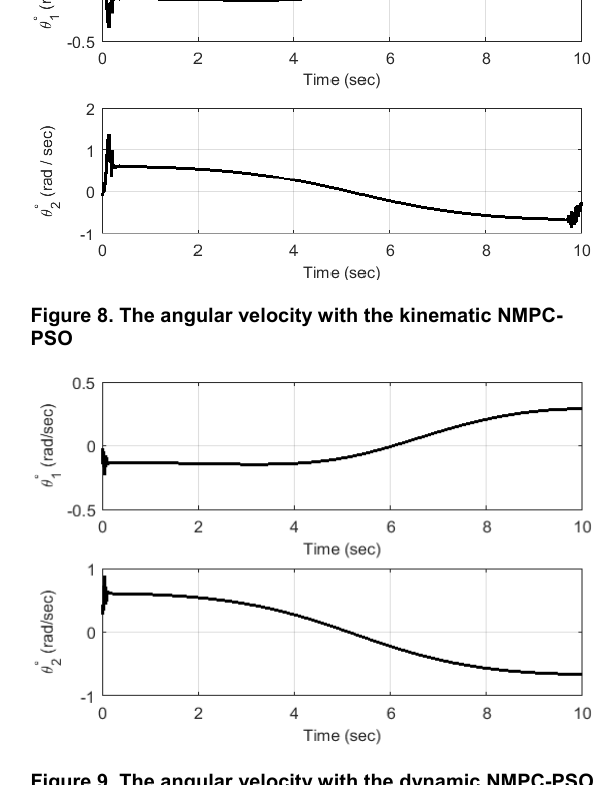
Figure 6. Actual and reference trajectories and the Euclidean errors between them using the kinematic model